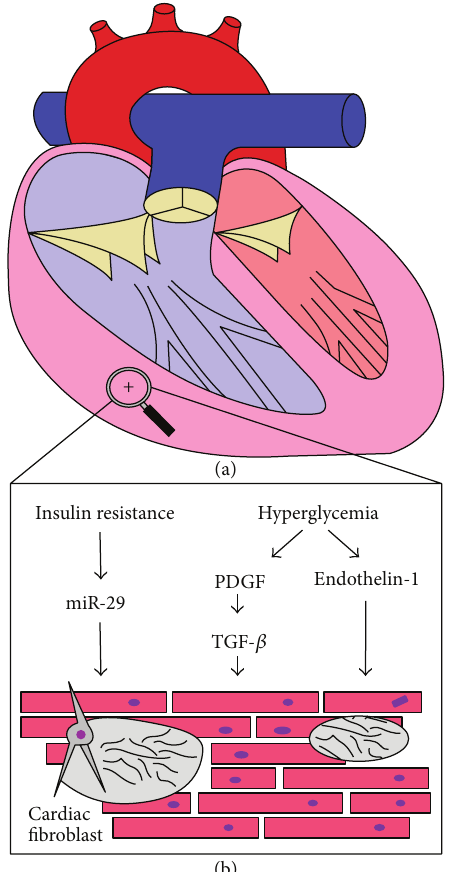
Figure 1: (a) Depiction of a heart with right ventricular hypertrophy and fibrosis. (b) Summary of the known pathways connecting diabetes to RV fibrosis and